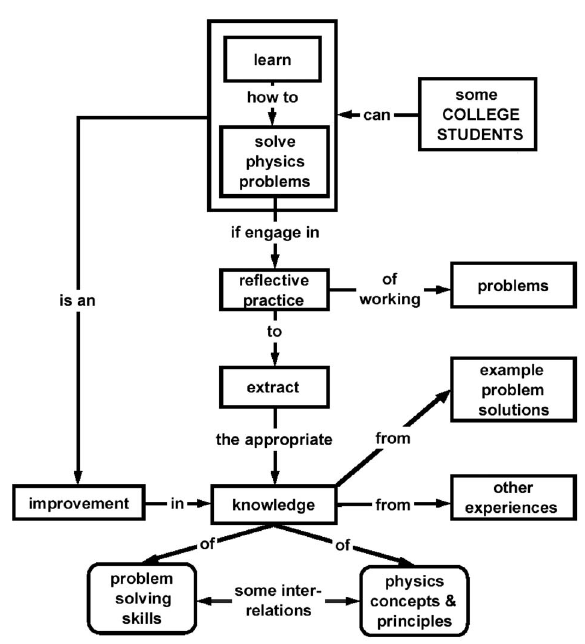
FIG. 1. Tentative main map developed at the beginning of the analysis process.